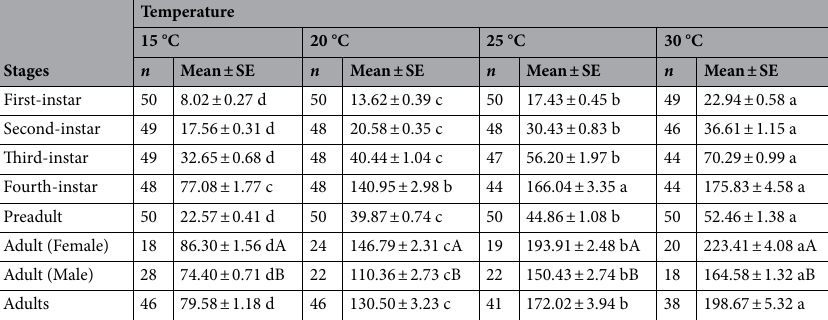
Table 3. Stage daily predation ( D j ) (preys/individual) (Mean ± SE) of Harmonia axyridis fed on Spodoptera litura eggs at four different temperatures. Standard errors were estimated by using the bootstrap technique with 100,000 resampling. Difference was compared using the paired bootstrap test ( P < 0.05). The means within a row followed by a different lowercase letters indicate significant differences among the temperatures, while different uppercase letters within the same column indicate significant differences between female and male adult stage daily predation.